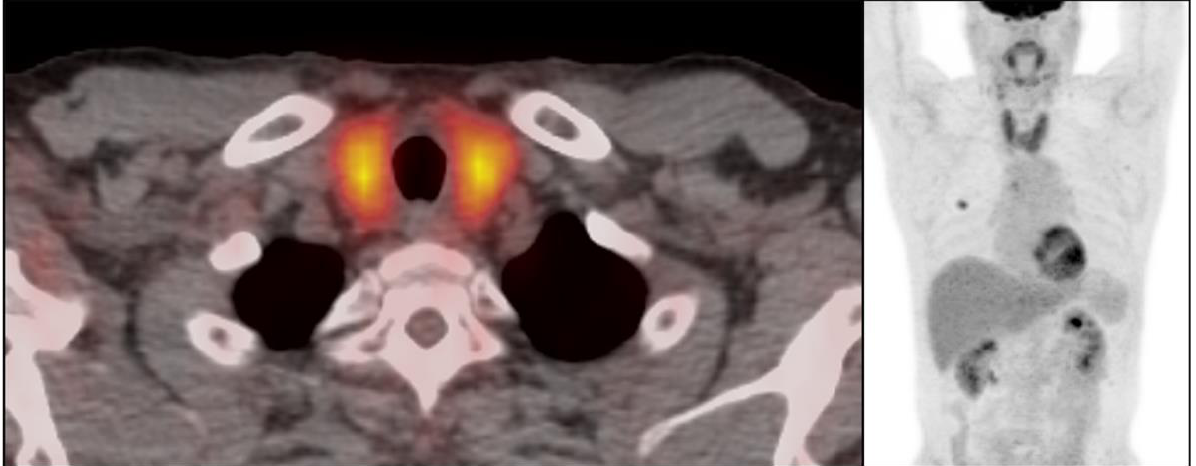
Figure 3. Imaging findings of immune-related thyroiditis on FDG-PET/CT. 57-year-old woman with advanced lung cancer treated with nivolumab monotherapy. After 7.9 weeks of therapy, there was a diffuse FDG uptake of thyroid gland representing immune-related thyroiditis.